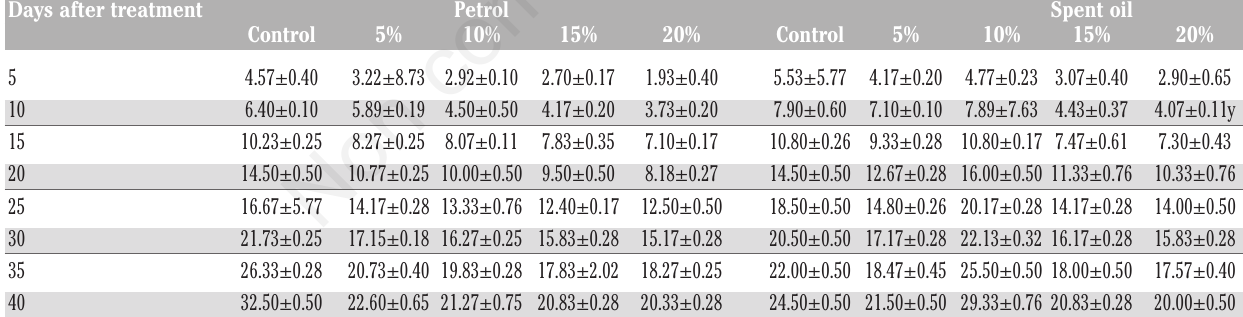
Table 3. Mean of the stem length of Guinea Corn seedlings in petrol and spent oil pollutants. Days after treatment